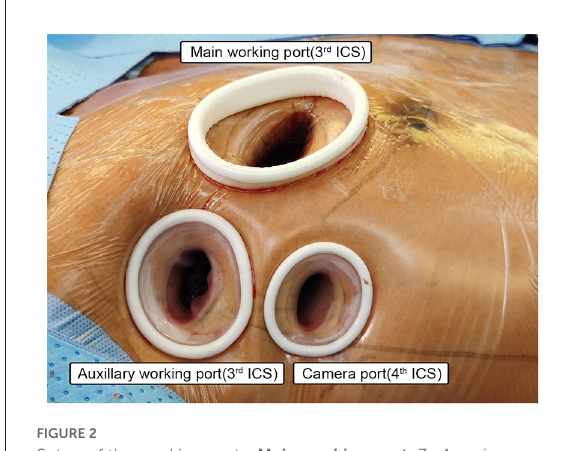
FIGURE2 Setup of the working ports. Main working port: 3–4cm in length, for patients with aortic valve insufficiency, the main working port was located between the midclavian line and anterior axillary line of the right 3rd intercostal space (ICS); in patients with aortic valve stenosis (AS), the main operating port was located between the parasternal line and the midclavicular line of the right 3rd ICS; mainly used for primary surgical instruments and delivery of cardioplegia. Auxiliary working port: 1.5–2cm in length, located between the anterior axillary line and the midaxillary line of the 3rd ICS, mainly used for placing a CHITWOOD aortic cross-clamp, a catheter for left ventricular venting, and instruments operated by the surgeon’s left hand. Camera port: 1–1.5cm in length, located between the 4th ICS between the anterior axillary line and the midaxillary